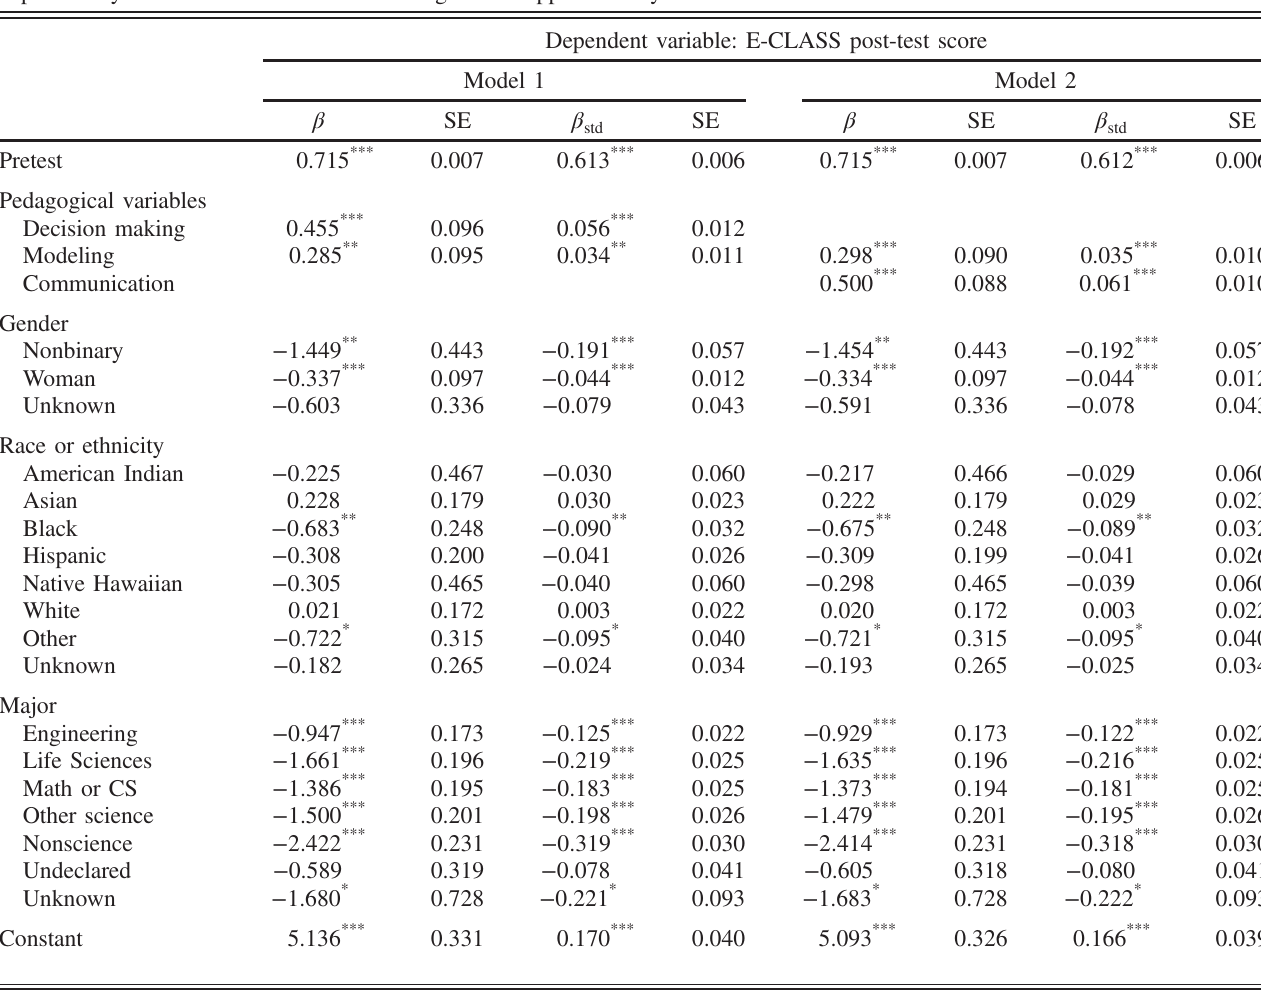
TABLE VI. Two-level linear mixed models of E-CLASS post-test scores including pedagogical and demographic variables with institution as a random intercept. Standardized coefficients represent effects with pretest and post-test scores grand mean centered. For nominal variables, effects are estimated relative to the reference level, which can be inferred by the level of the variable that is not shown in the table. The percent variance explained by the fixed effects alone is approximately 41% for both models. The percent variance explained by the fixed and random effects together is approximately 44% for both